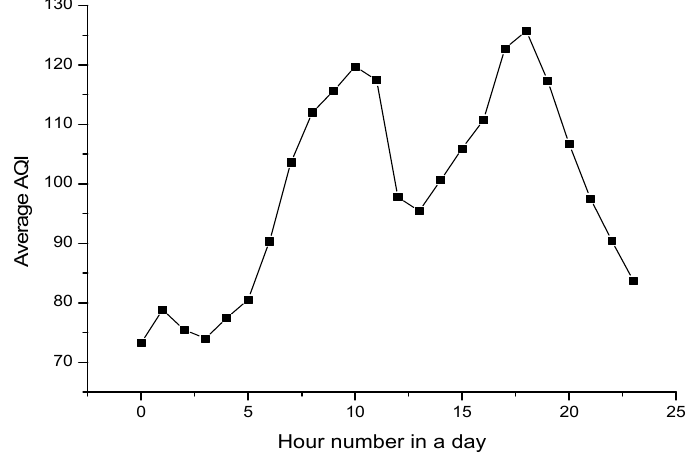
Figure 11. The average AQI within different hour in a day.